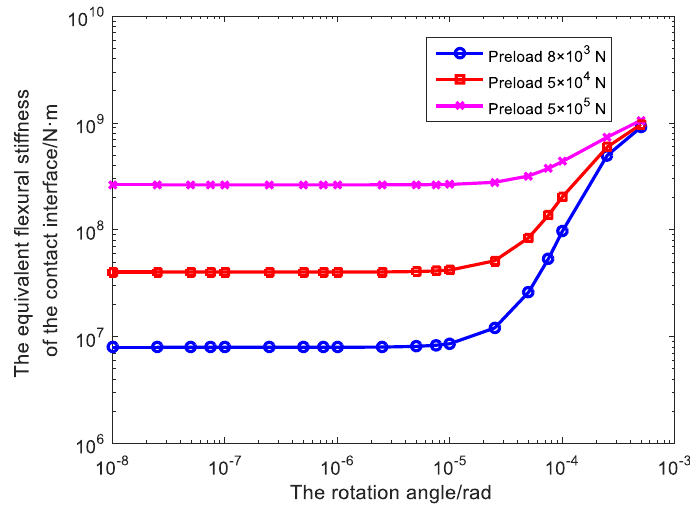
Figure 7. Equivalent flexural stiffness (EFS) of the contact surface changes with the rotation angle.